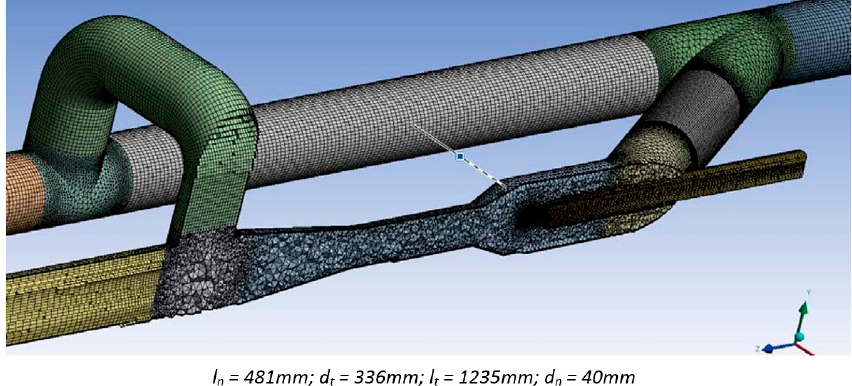
Figure 11. Mesh of the Jet pump.